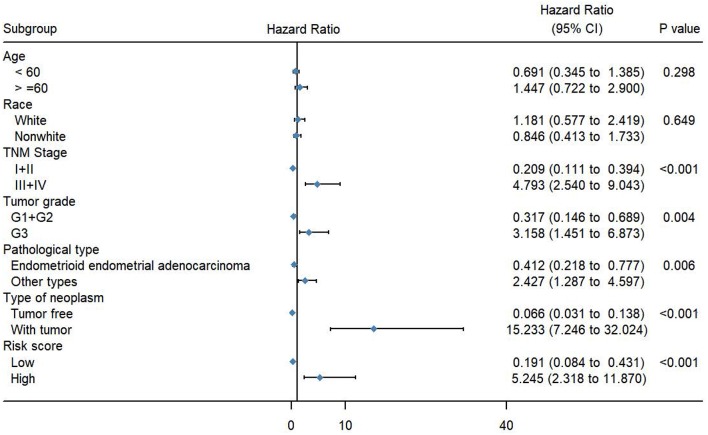
Forest map of clinical characters in univariate analysis. The coordinate of diamond represents the odds ratio. Univariate Cox regression analysis was performed. Subgroup with a value of p < 0.05 was considered statistically significant.